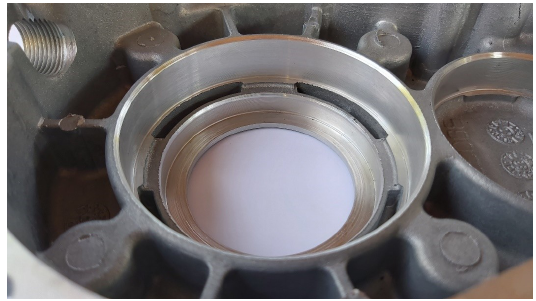
Figure 13. Oil seal and bearing